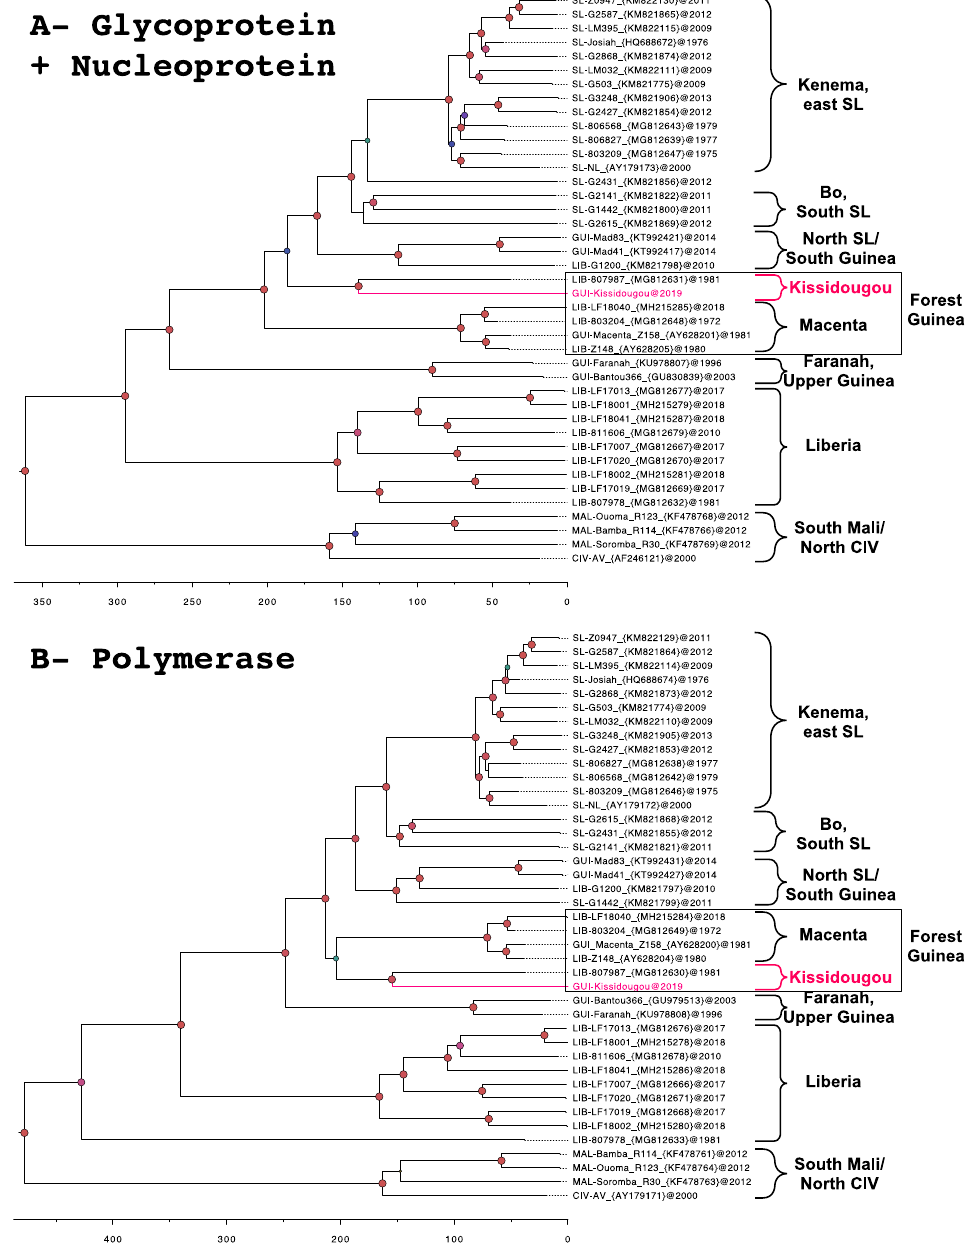
Figure 2. Time-calibrated phylogeny of the Lassa virus strains, gathering 41 sequences belonging to lineages IV and V (i.e., represented by “South Mali / North CIV”) and showing the new one from Kissidougou (in pink). The trees show the complete glycoprotein precursor and nucleoprotein in a linked model ( A ), and the complete polymerase ( B ). The trees were inferred by using the Bayesian Markov chain Monte Carlo method, with GTR + gamma model, strict clock, constant population size and partitioning into codon positions 1, 2, 3. Posterior probabilities are coded as follows: 0.7, green dots; 0.80 to < 0.85, purple-blue dots; > 0.97, red dots. Geographical origins are noted on the right of each tree, and scale axis represents the time in